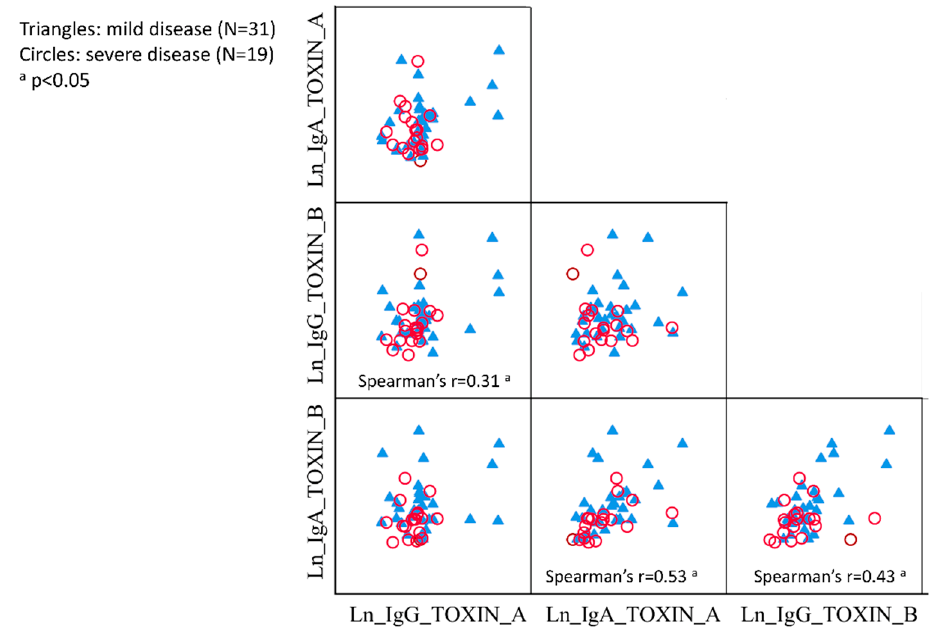
Figure 1. Correlation matrix between serum IgG and IgA levels against toxin A and toxin B of Clostridium di ffi cile in patients with mild and severe CDI. CDI: Clostridium di ffi cile infection; IgA: Immunoglobulin A; IgG: Immunoglobulin G; Ln natural